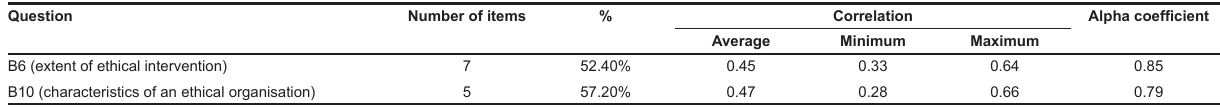
TABLE 2 Principal component analysis: ethics interventions and characteristics of ethical organisations (low correlation variable